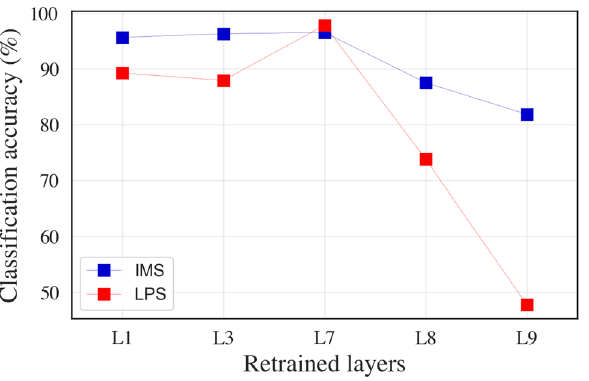
Figure 3. Impact of retraining individual layers in deep TL-CNNs for parameter transfer (while keeping weights of other layers frozen) for scalograms (layer names as per Table 2) used as